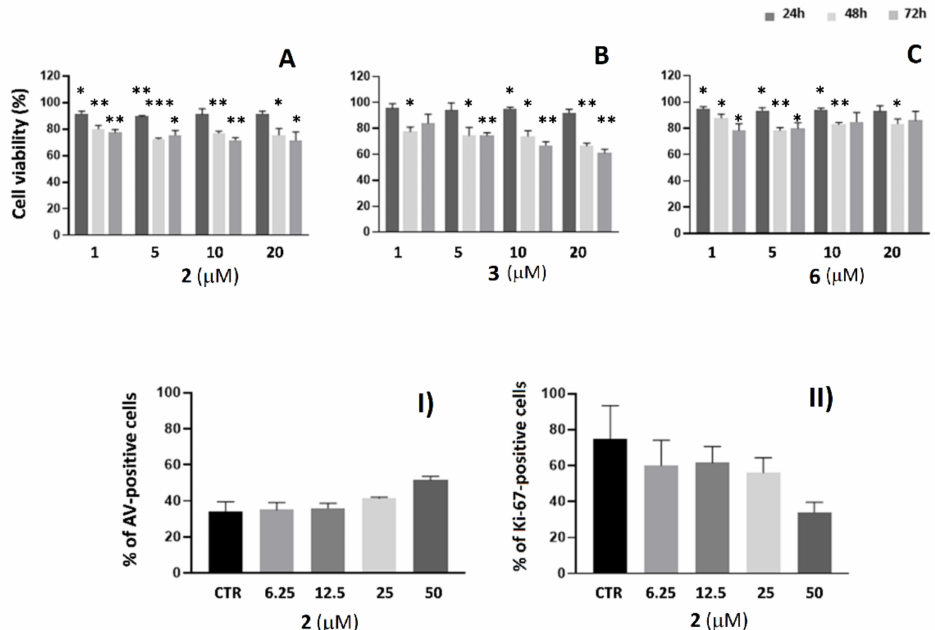
Figure 5. Upper graphs from ( A – C ): growth inhibition of NK92 cells measured by WST-8 assays. Cells were maintained for 24, 48, and 72 h at 37 ◦ C alone or in the presence of 20 µ M, 10 µ M, 5 µ M, and 1 µ M of AE ( A ), glutaryl derivative of AE ( B ), AE-CPP-LTV ( C ). Data were expressed as cell metabolic activity, calculated as absorbance value of cells treated with different compounds/absorbance values of control cells * 100%. Data are reported as mean ± standard deviation from two independent experiments. * p < 0.05, ** p < 0.01, *** p < 0.001 versus untreated cells. Bottom panel: ( I ) Apoptosis was determined by AnnexinV (AV)-FITC staining in NK92 cells after 48 h of incubation with or without different amounts of AE ranging from 6.25 to 50 µ M. Data are expressed as mean ± standard deviation from 2 independent experiments. ( II ) Proliferation was evaluated by flow cytometry measuring Ki-67 nuclear antigen expression using FITC-labelled anti-human Ki-67 mAb staining in NK92 cell after 48 h of incubation in the absence or presence of different amounts of AE. Data are expressed as mean ± standard deviation from 2 independent experiments.